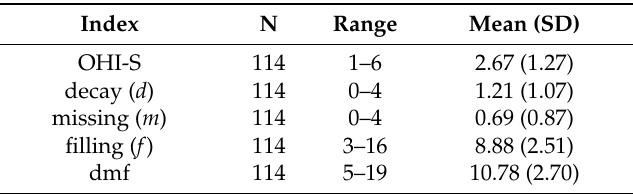
Table 1. Oral health status of the patients at the time of